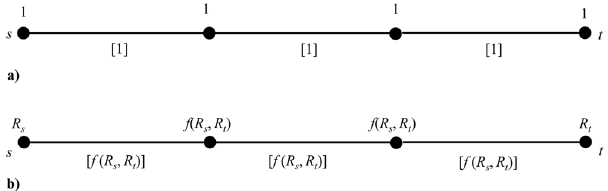
Figure 3. ( a ) Assignment of the standard betweenness to internal elements of a shortest path between vertices s and t . The values referred to the vertices are reported above the path and those referred to the edges, shown in square brackets, are reported below the path. Notice that the betweenness of traversed vertices (or edges) has a unitary increment. ( b ) Betweenness embedding intrinsic relevance. In this case, the betweenness increment of traversed vertices (or edges) is computed from f ( R s , R t